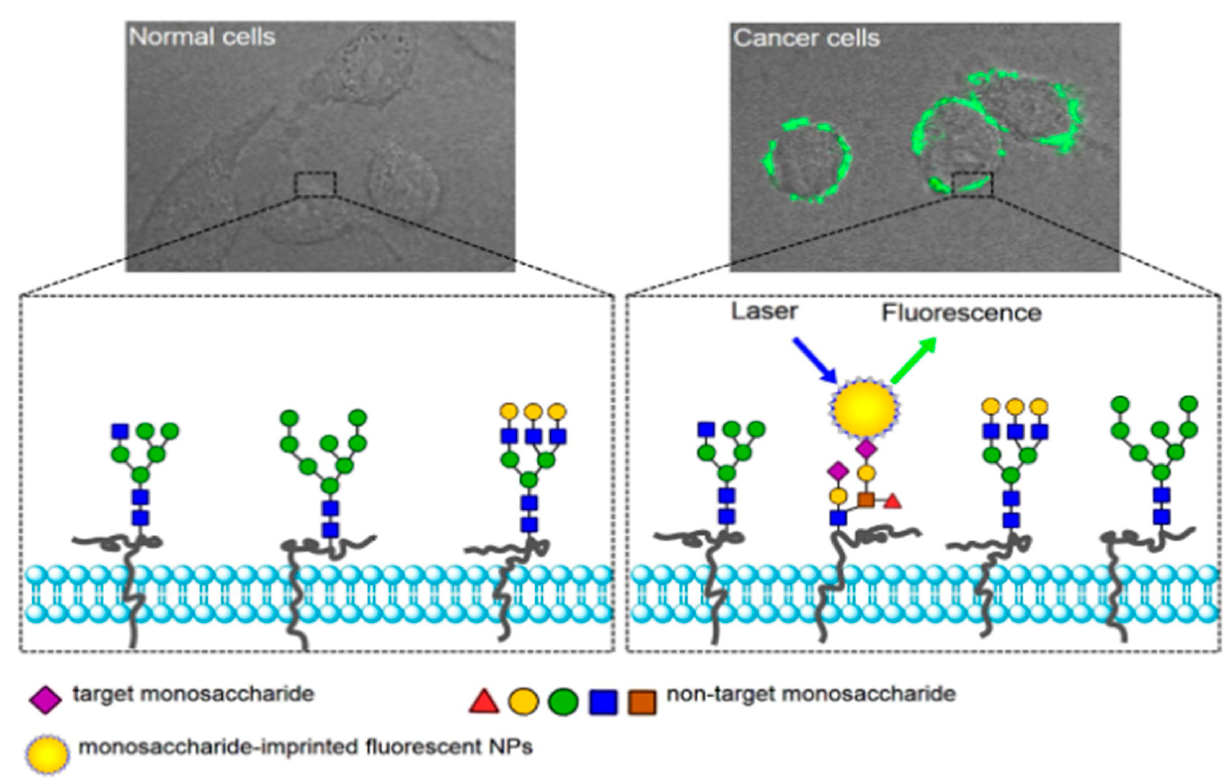
Figure 6. Targeting and imaging of cancer cells with monosaccharide-imprinted NPs. CC-BY license [73] Copyright 2016, Springer Nature .